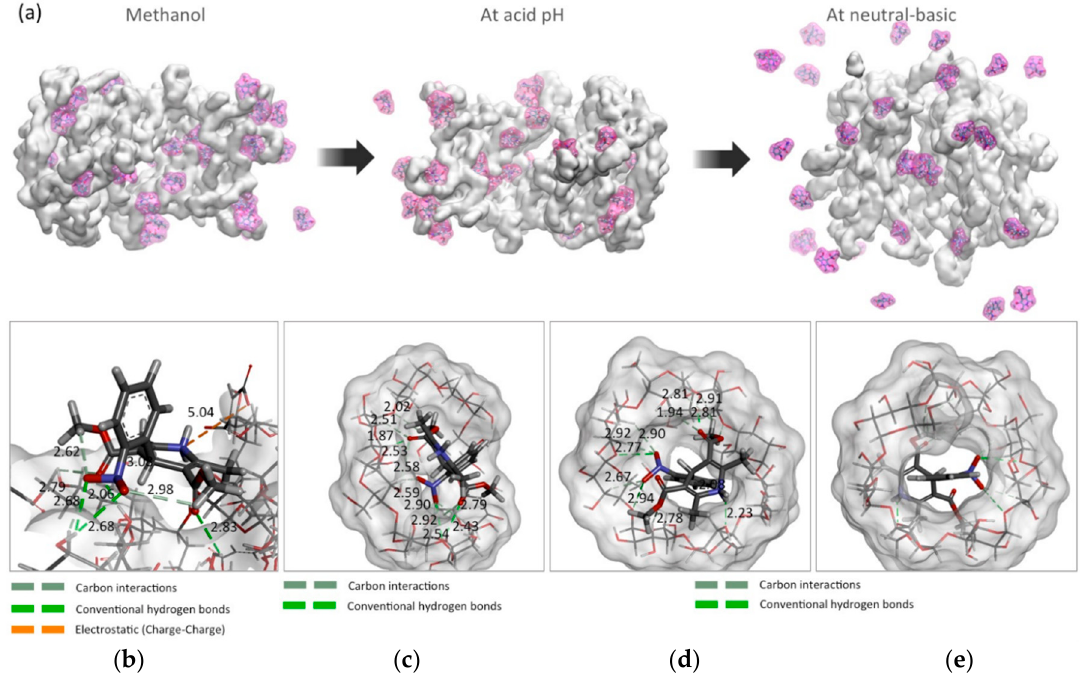
Figure 4. ( a ) Snapshots of the final results of each molecular dynamics simulation between γ -CDPVAHMA and NFD in methanol and in environment of acid and neutral-basic pH. Snapshots of the main intermolecular interactions generated between γ -CDPVAHMA and NFD: ( b ) in superficial nano-cavities of the hydrogel; ( c ) with the hydrophobic cavities of γ -CD added to the hydrogel; and ( d , e ) front and back face of the γ -CD/NFD inclusion complex.